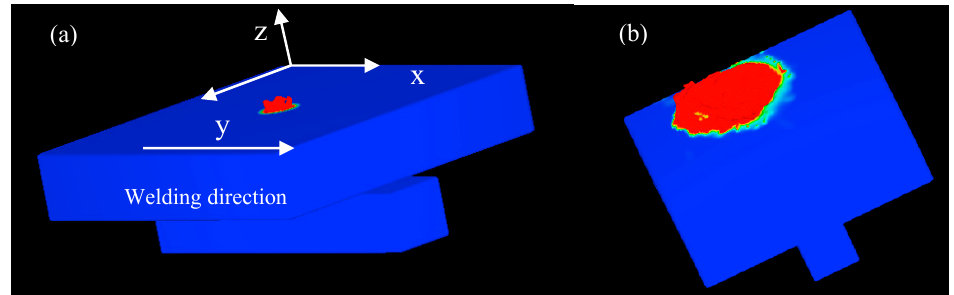
Figure 2. The three dimensional simulated profile with the gap of 0.2 mm: ( a ) t = 0.01 s; and ( b ) t = 0.02 s.